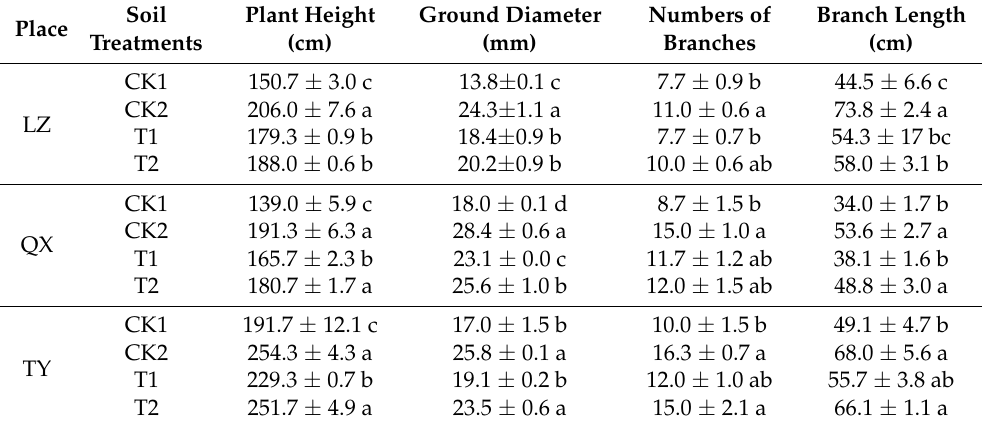
Table 2. Effects of different treatments on the biomass of apple replanting saplings in three areas. Soil Plant Height Ground Diameter Numbers of Place Treatments (cm) (mm) Branches